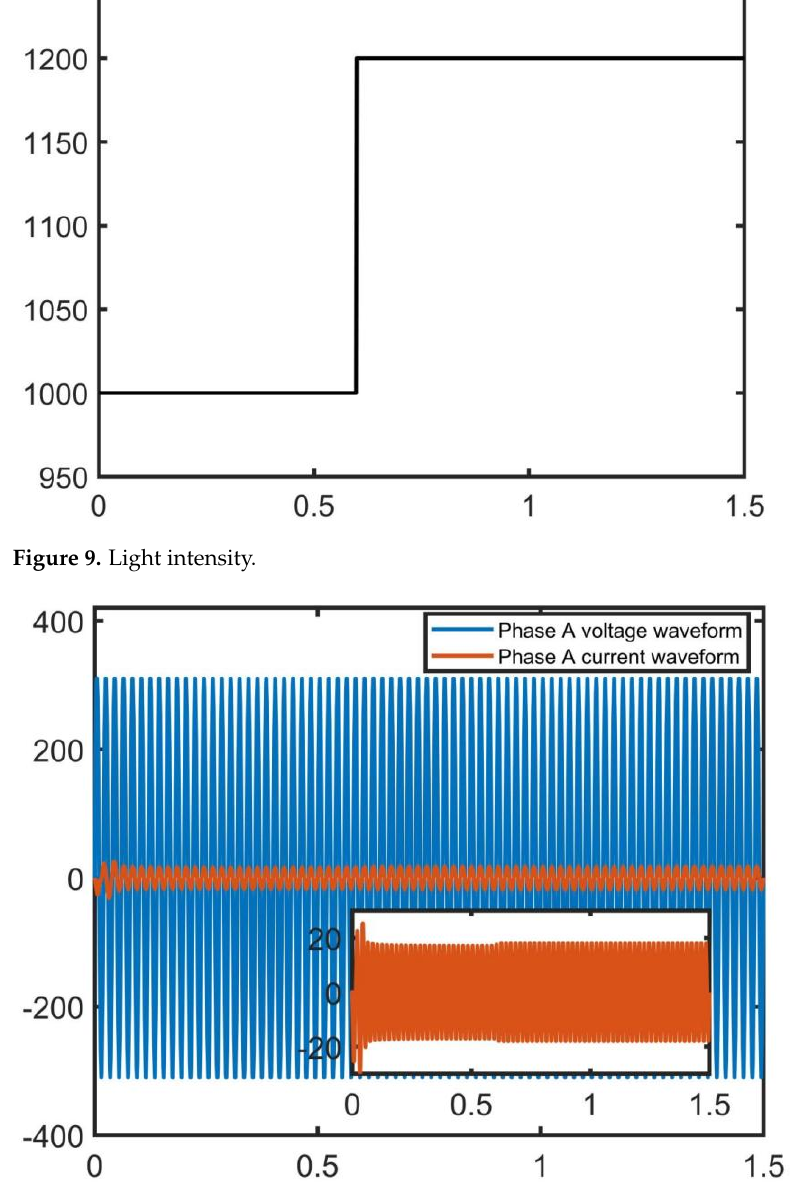
Figure 10. Phase A voltage and current waveform.